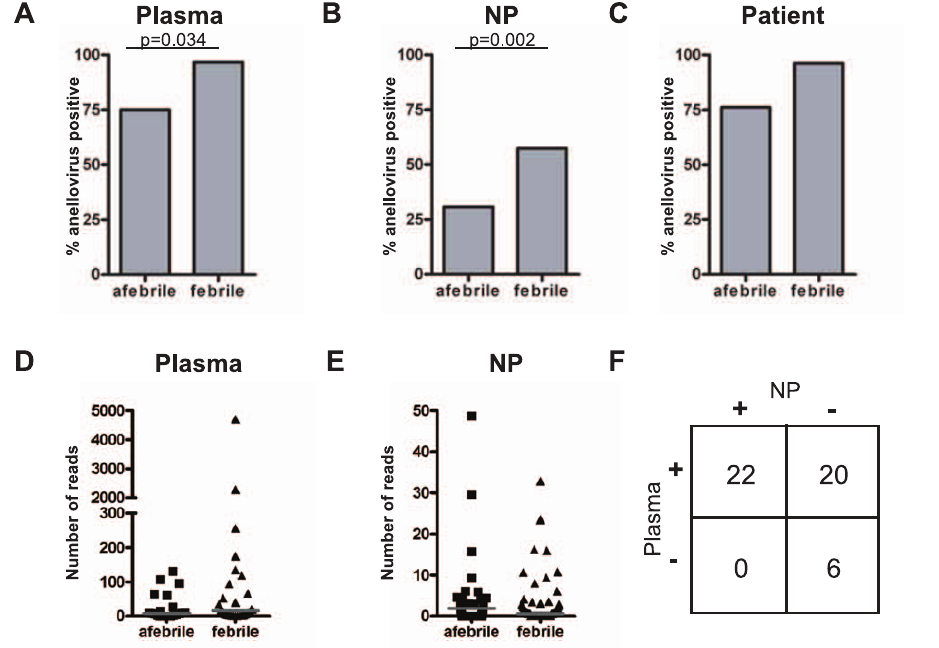
Figure 1. Anellovirus DNA was more prevalent in specimens from febrile children by high-throughput sequencing. A–B . High- throughput sequencing analysis of plasma ( A ) and NP ( B ) specimens showed that a higher percentage of specimens from febrile children contained anellovirus DNA compared to specimens from afebrile children (plasma, p=0.034; NP, p=0.002). C . The trend was the same, but not statistically significant at the patient level of analysis. D–E . Afebrile and febrile patients had a similar median number of anellovirus sequence reads in their plasma (10.2 vs. 15.6) ( D ) and NP (2.9 vs. 1.7) ( E ) specimens. F . Anellovirus sequences detected by high-throughput sequencing were more prevalent in plasma compared to NP specimens (p , 0.0001; Chi-squared test).